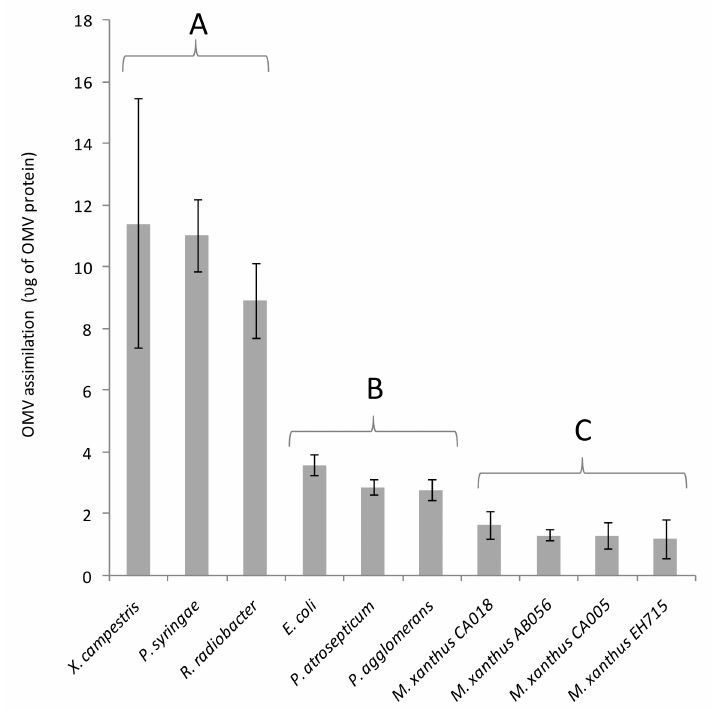
Figure 2. Assimilation of OMVs by a panel of Gram-negative bacteria. Error bars represent ± 1 standard deviation ( n ≥ 3). A, B and C represent groups of organisms that exhibited substan- tially different OMV assimilation values from members of other groups. No statistically significant differences were observed within groups (Bonferroni corrected p < 0.05), but were observed between groups. Organisms are ordered by apparent fusion